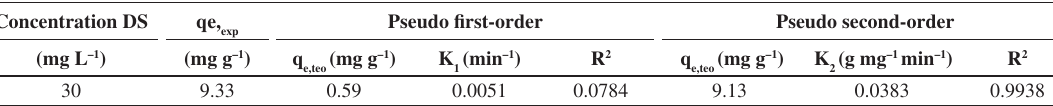
Table 3. Parameters pseudo-first order and pseudo-second order for adsorption of the drug DS by Cacen. Concentration DS qe, Pseudo first-order Pseudo exp